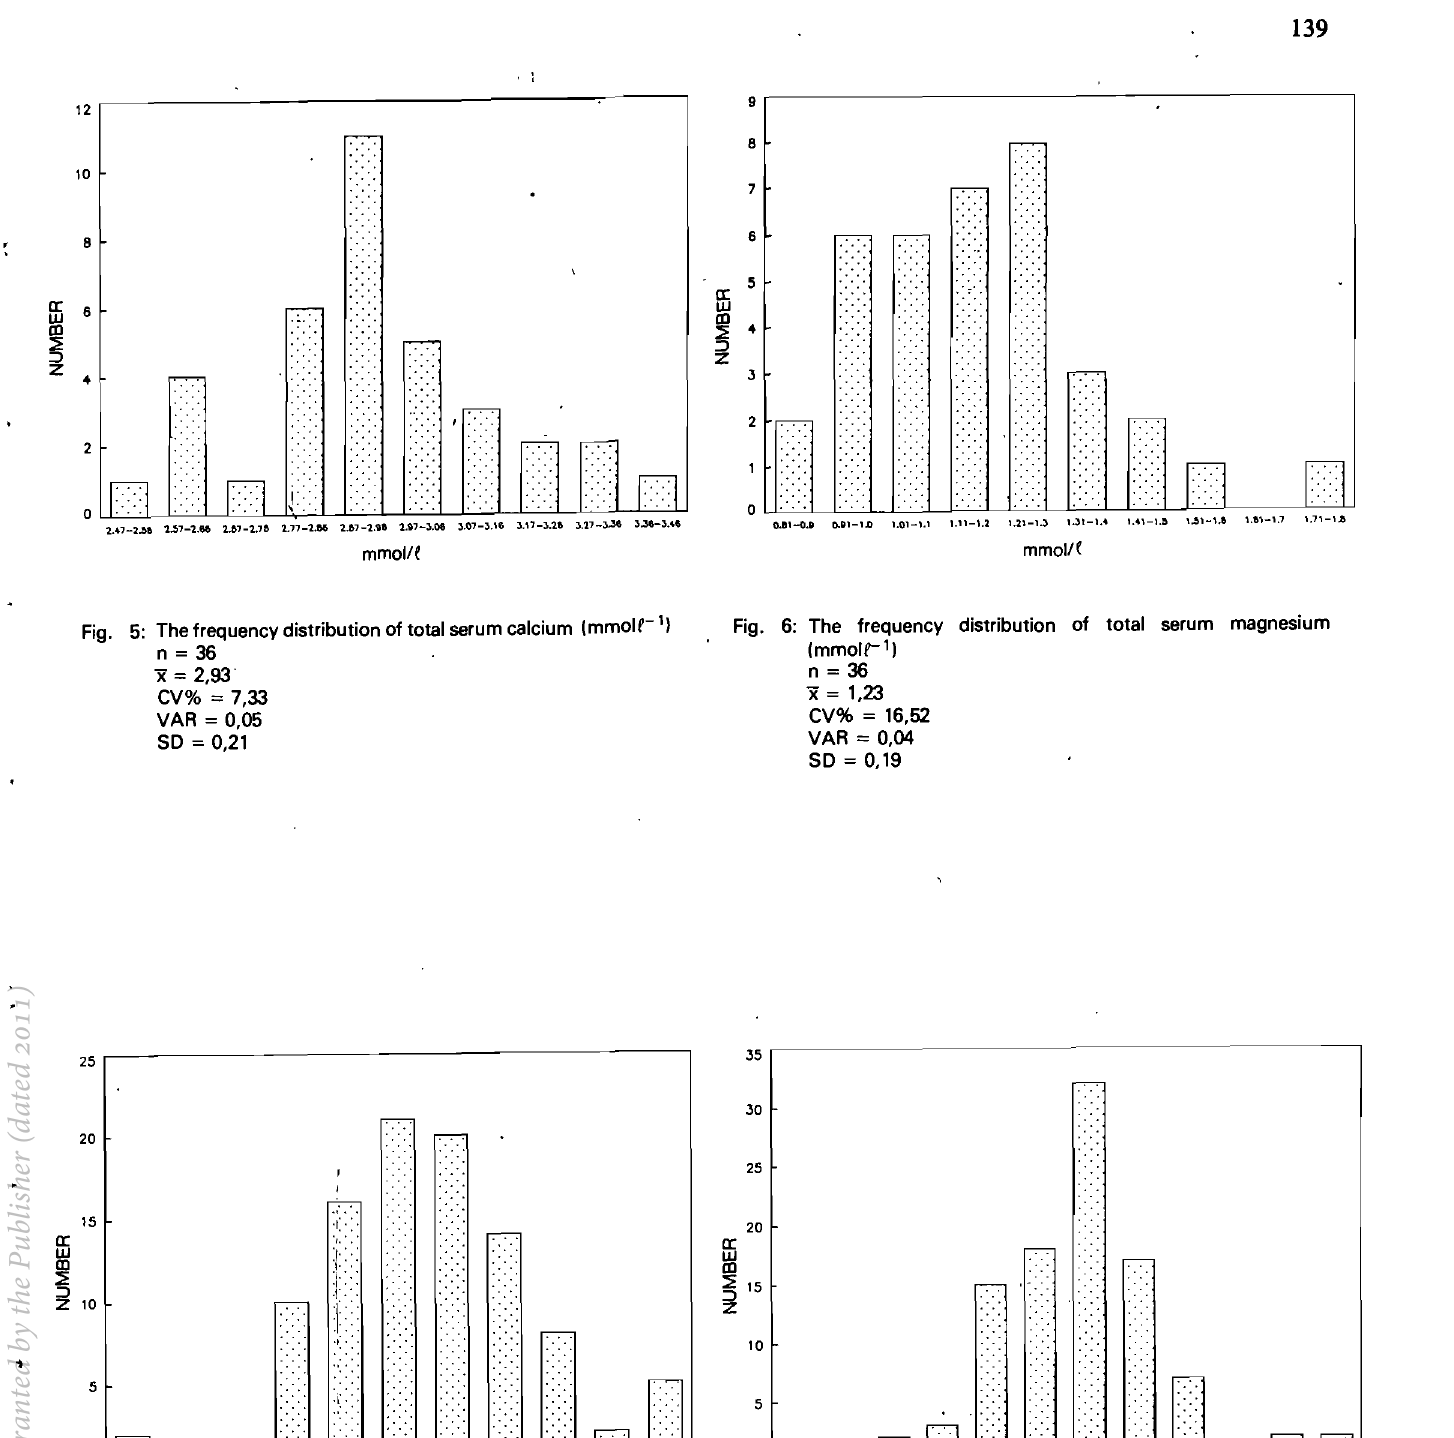
Fig. 8: The frequency distribution oftotal serum proteins (ge- 1) n = 100 x = 62,20 CV% = 14,02 VAR = 76,00 SO =